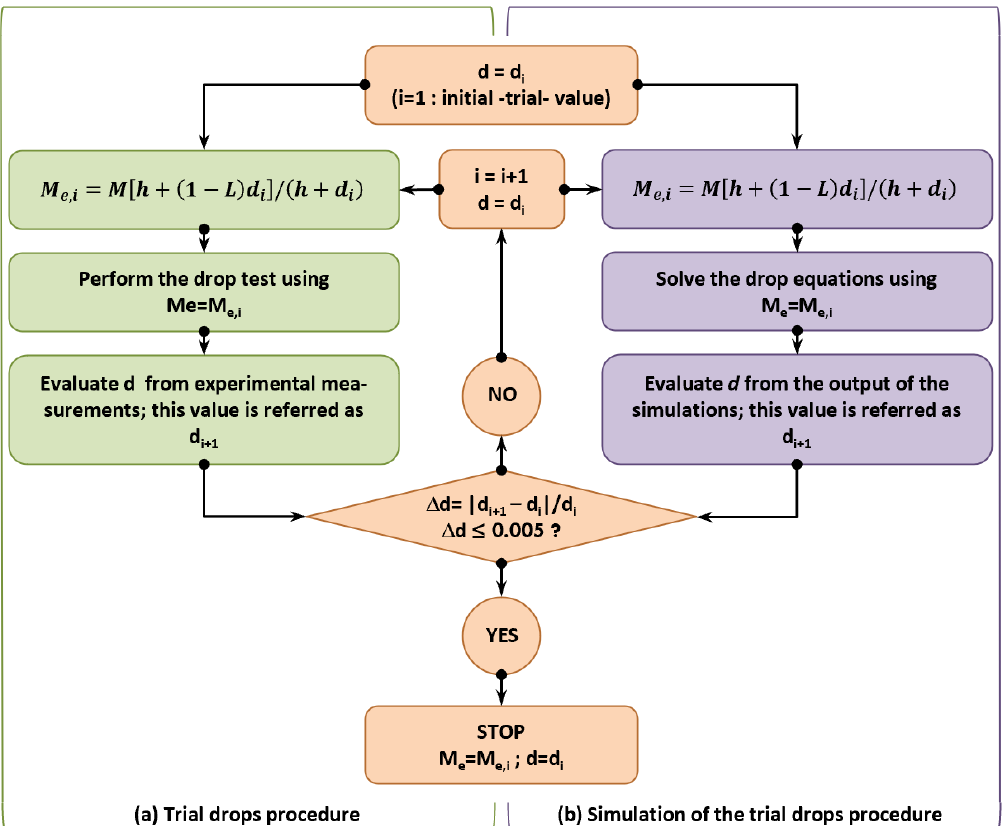
Figure 6. Iterative process for determining effective mass: ( a ) trial drop tests and ( b ) numerical